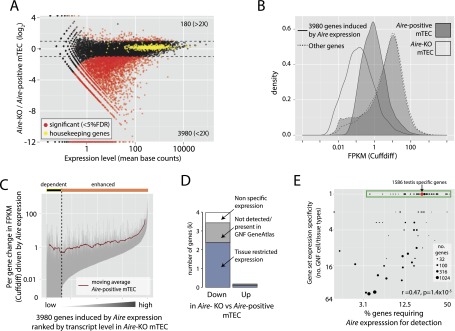
Aire expression positively regulates a large set of tissue-restricted genes. (A) Genes differentially expressed between mature Aire-positive mTEC and mature Aire-KO mTEC (<5% FDR, more than twofold). A set of 474 housekeeping genes (de Jonge et al. 2007) showed little change in expression, indicating the absence of a systematic bias (yellow points). (B) At the population level, Aire expression elevates target gene transcription to a median FPKM of 1. (C) Aire expression differentially up-regulates individual target genes. Each gray vertical line represents the change in FPKM of a single gene between mature Aire-KO mTEC and mature Aire-positive mTEC. Genes are ordered by increasing expression in mature Aire-KO mTEC on the x-axis, being either dependent on or enhanced by Aire expression. The red line represents the moving average of FPKM in mature Aire-positive mTEC. (D) Genes induced by Aire expression are tissue-restricted in transcription. Tissue-restricted genes were identified from the GNF GeneAtlas using the dynamic step method (Methods; Supplemental Fig. 6). (E) Degree of tissue restriction is positively correlated with the requirement for Aire expression. The fraction of genes requiring Aire expression for detection was assessed for sets of genes restricted in expression to all possible branches, nodes, and leafs of the GNF GeneAtlas sample clustering (Supplemental Fig. 6A). Only gene sets with at least 10 members are shown. The red dot indicates 1586 genes restricted in expression to testis, a tissue with a transcriptome of abnormally high complexity (Ramsköld et al. 2009) that is known to express Aire and to undertake PGE (Schaller et al. 2008).